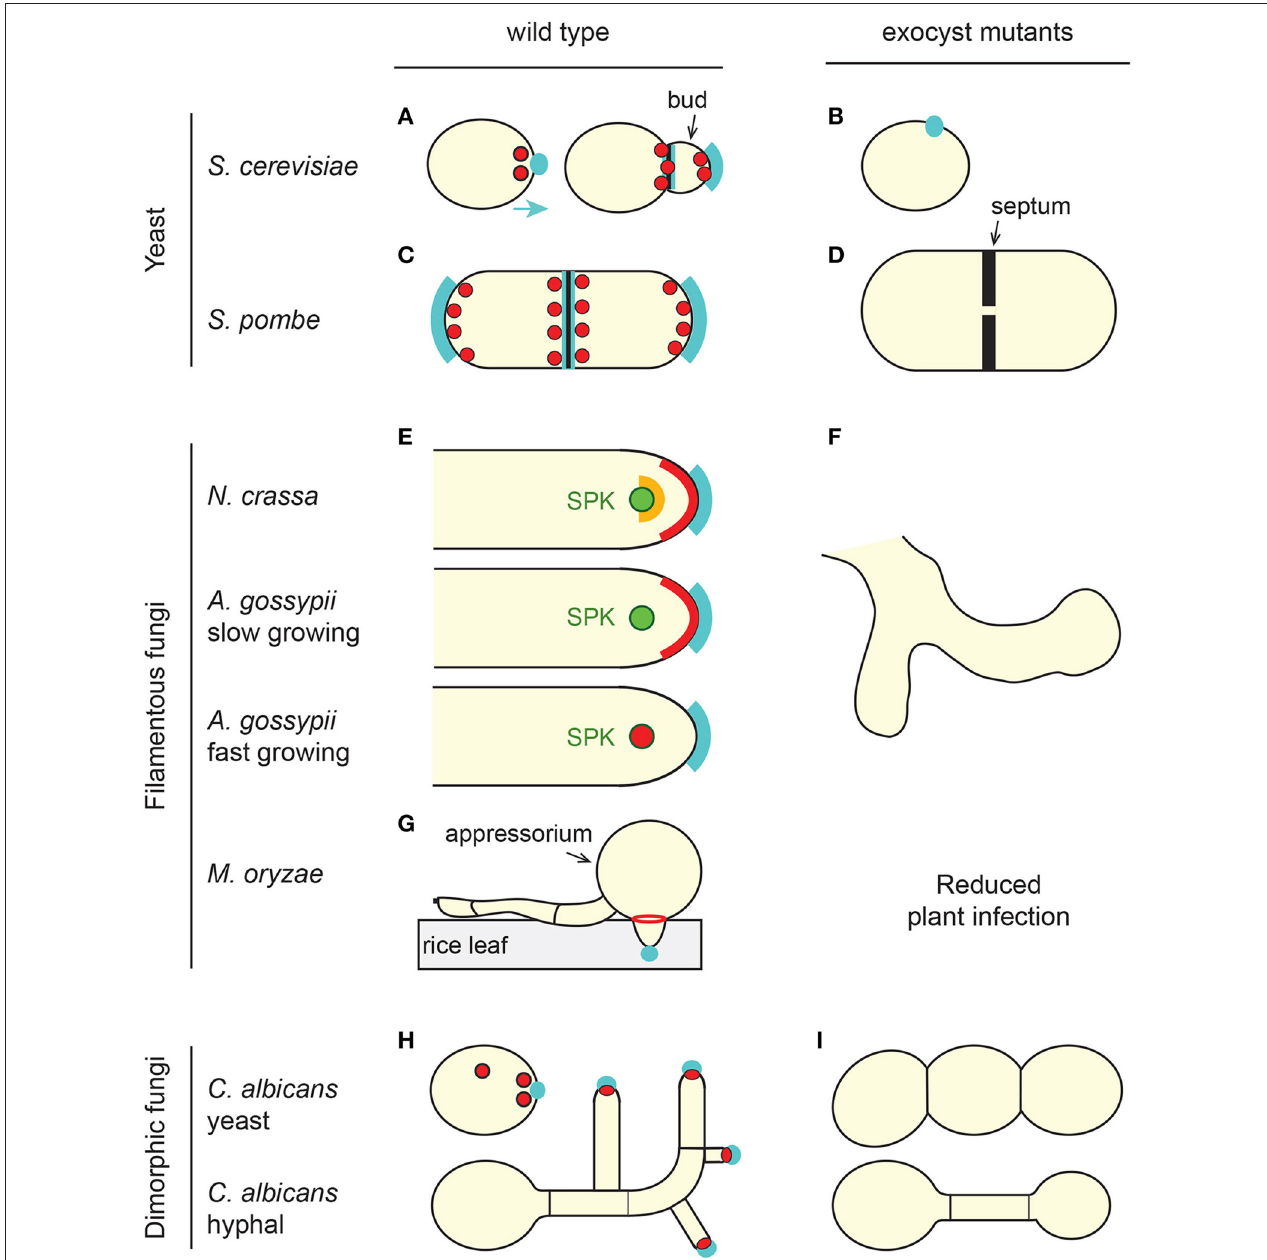
FIGURE 1 | The exocyst complex in fungi. (A,C,E,G,H) Overall localization of the exocyst complex (red and orange) in wild-type cells of representative fungi. For simplicity, S. pombe cells (C,D) are represented as both elongating and dividing. In all fungi, the exocyst localizes at sites of polarized secretion and polarized growth (cyan), the bud tip in budding cells (A,H) , cell tip area in tip-growing fungi (C,E) or septal area in dividing cells (A,C) . In some cases individual sub-units or sub-complexes are present at different sub-cellular locations, which is only illustrated here for N. crassa ( E , red and orange). The exocyst localizes as a ring at the base of the M. oryzae appressorium during rice leaf infection (G) . SPK, Spitzenkörper (green). (B,D,F,I) Typical cellular phenotype of exocyst mutants. In the absence of a functional exocyst, most fungal species have a morphological or loss of polarity phenotype, failing to grow a bud (B) , growing wider (D) , branching out (F) , or failing to branch (I) . Note that in the case of the hyphal form of C. albicans , three different phenotypes were described. We arbitrarily present here a hypo-branching and globular tip phenotype reported for a sec3 defective mutant. Some fungi also have a cytokinetic defect (D,I) . See text for details and references.